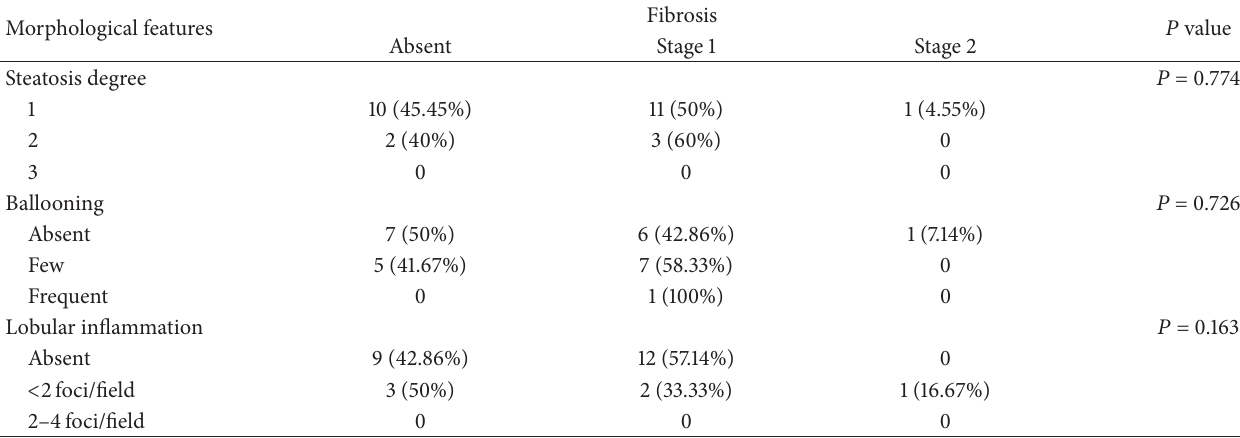
Table 3: Association between morphological features and fibrosis grade in non-NASH biopsies according to Bedossa’s histological algorithm. Morphological features